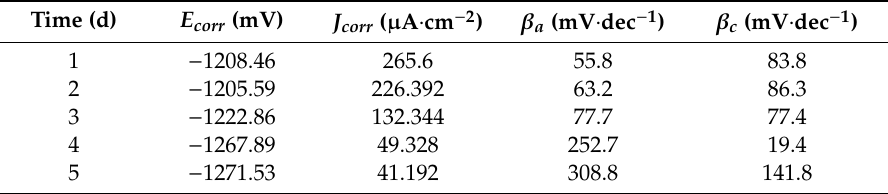
Table 3. Polarization results of 12Cr1MoV steel.